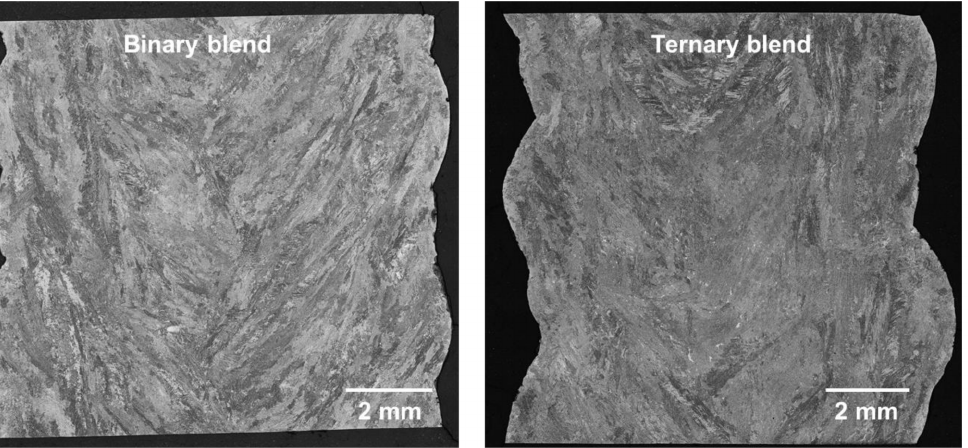
Figure 7. Thickness of wall cross-sections deposited using binary ( left ) and ternary ( right ) gas blends.